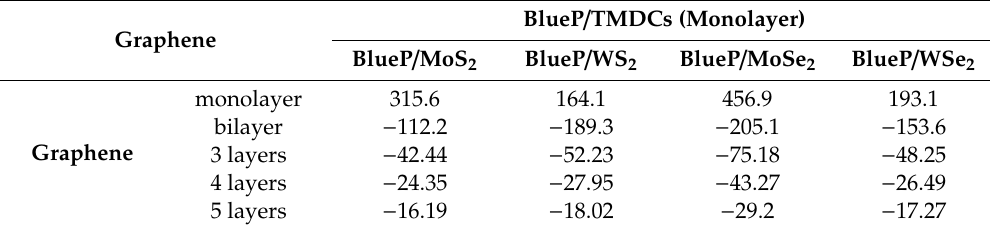
Table 4. The optimal GH shift (S / λ ) with BlueP / TMDCs monolayer and di ff erent number of graphene. Graphene